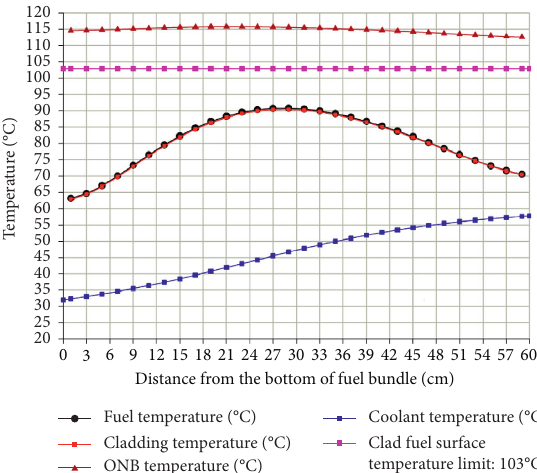
Figure 7: Calculated temperatures at nominal power without hot channel factors in the hottest FB.